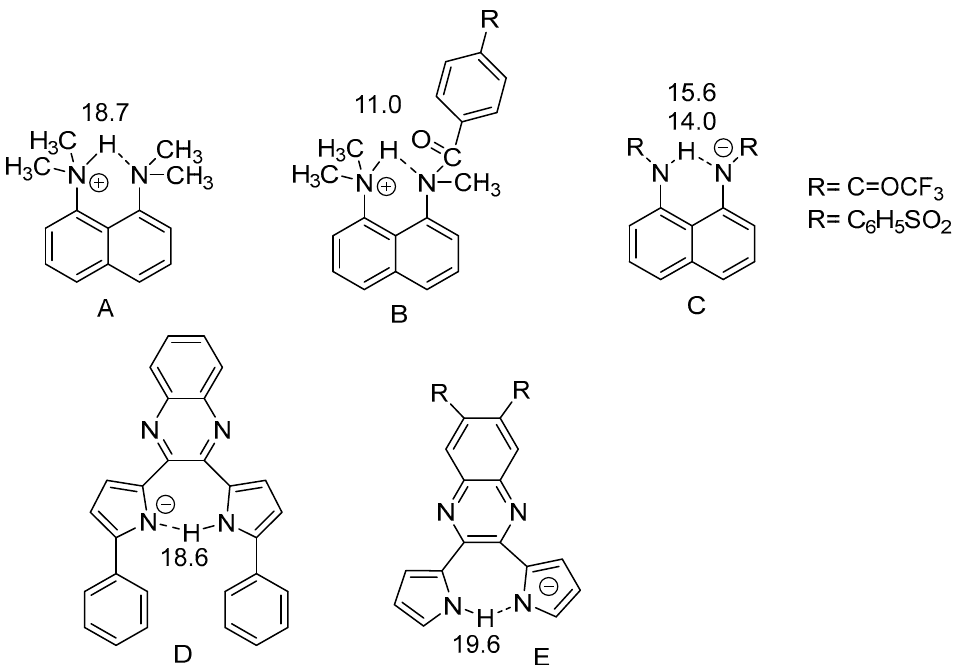
Figure 15. Hydrogen bonding of DMAN types ( A – C ). Counter ions are left out, but the numbers vary slightly with the counter ion. ( C , D ) are hydrogen bonding to a negative acceptor. Numbers are NH chemical shifts. ( A ) from [53], ( B ) and ( C ) from [54]. ( D ) from [55]. ( E ) from [56].